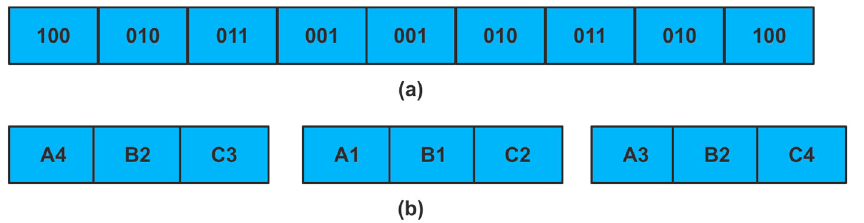
Figure 7. Three cluster centers and its corresponding coding scheme: ( a ) the coding scheme of the three cluster centers; ( b ) three cluster centers (A4,B2,C3), (A1,B1,C2) and (A3,B2,C4).